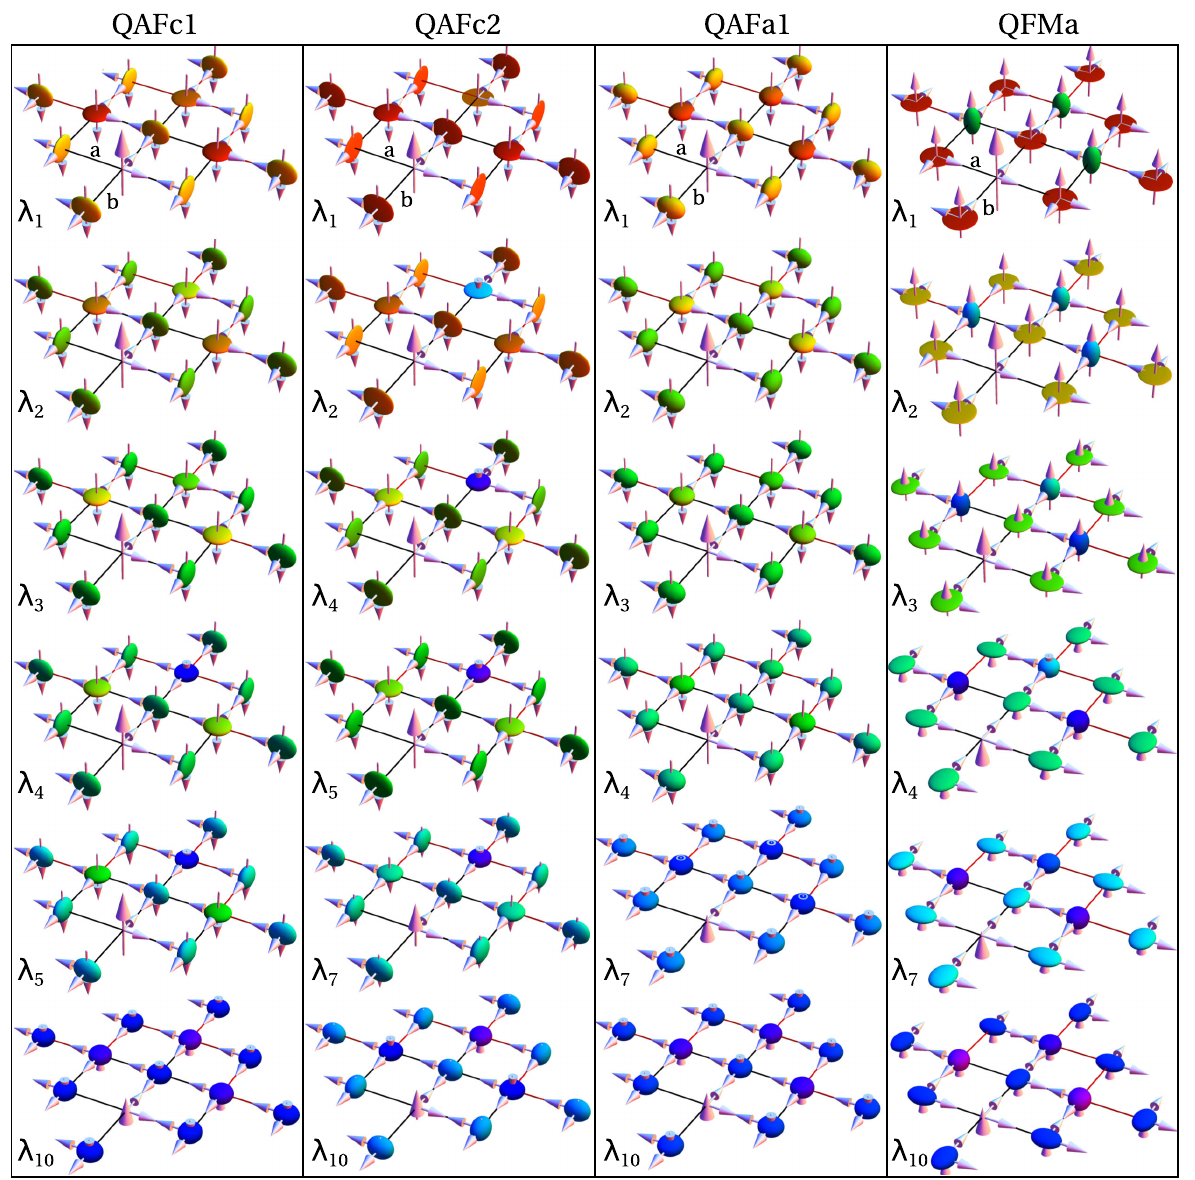
FIG. 14. Evolution of the ground-state configurations for the AF phases for selected increasing values of spin-orbit coupling λ Eq. (28). Arrows and ellipsoids indicate the spin-orbital state at a given site i . The color map indicates the strength of the average spin orbit h ~L · ~S ; i.e., red, yellow, green, blue, and violet correspond to the growing amplitude of the above correlation function. Small i i i arrows at λ 5 and λ 10 indicate quenched magnetization at the impurity by large spin-orbit coupling at the neighboring host